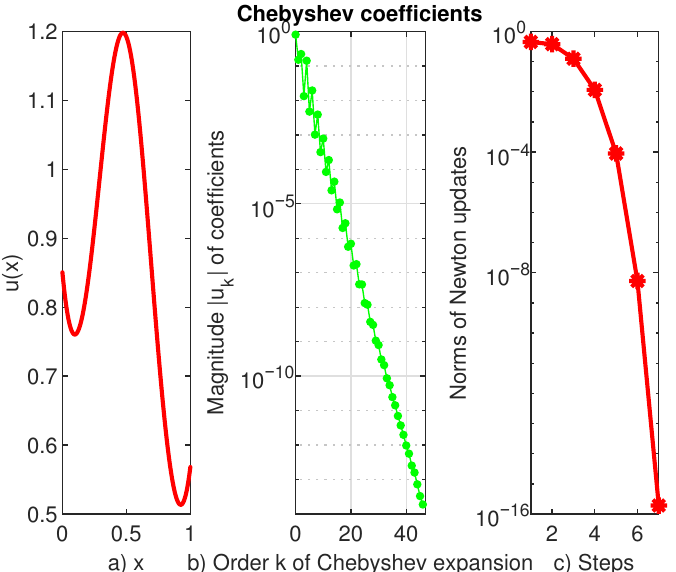
Figure 2. ( a ) The Chebfun solution to problem (8) is depicted. ( b ) In this panel we report the behaviour of Chebyshev coefficients of solution to problem (8) when N = 47. ( c ) Newton’s method appears to be of second order and uses seven iterative